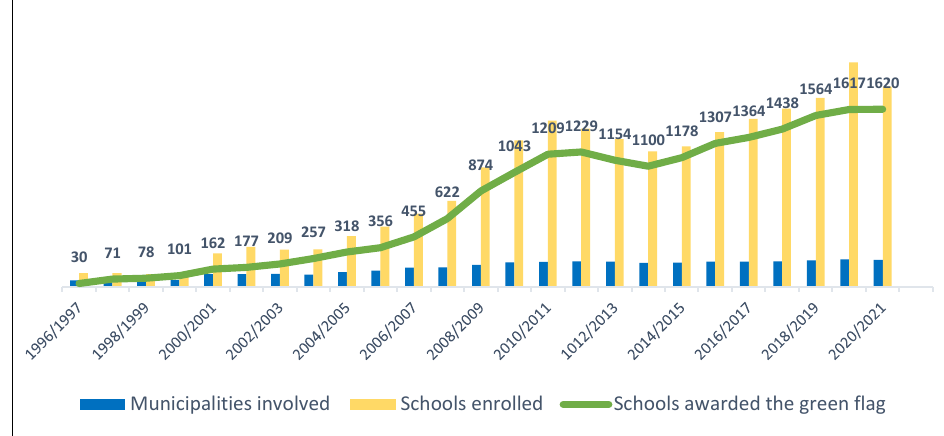
Figure 1. Municipalities involved, schools enrolled, and schools awarded the Green Flag. Source: (ABAE 2021, 2022a).